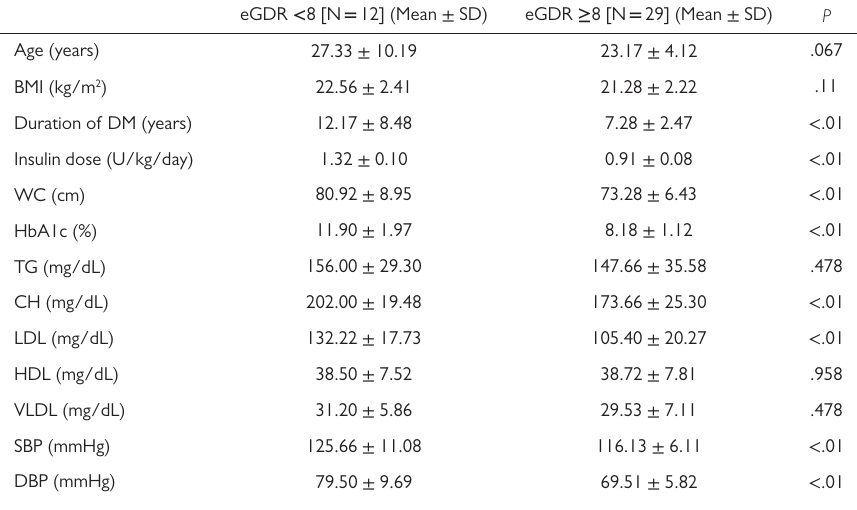
Table 4. Comparison of Various Characteristics of Patients with eGDR < 8 and eGDR ≥ 8 in